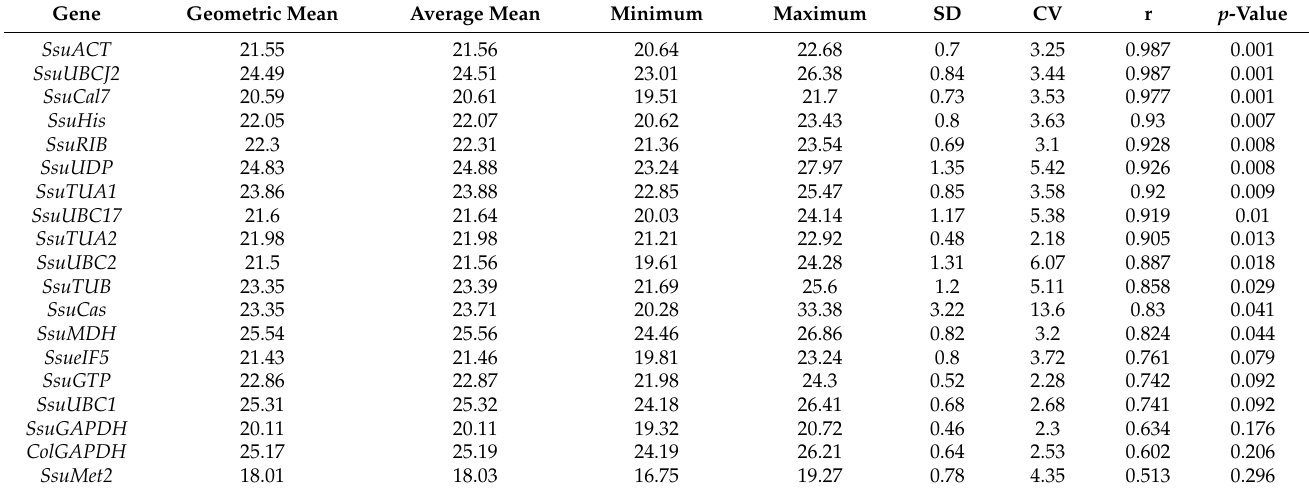
Figure 3. Expression stability of candidate reference genes analyzed by NormFinder. Expression stability is represented by the standard deviation (SD), coefficient of variance (CV), and correlation coefficient (r) of Ct values in the BestKeeper program, and the most stable reference genes were identified as those with the lowest SD and CV and the most r [28]. In this study, SsuACT and SsuUBCJ2 were identified as the most stable genes for different tissues, while SsuUBC17 , SsuTUB , SsuUBC2 , SsuUDP , and SsuCas were unstable because of SD > 1 (Table 3). Table 3. Expression stability of candidate reference genes analyzed by BestKeeper.